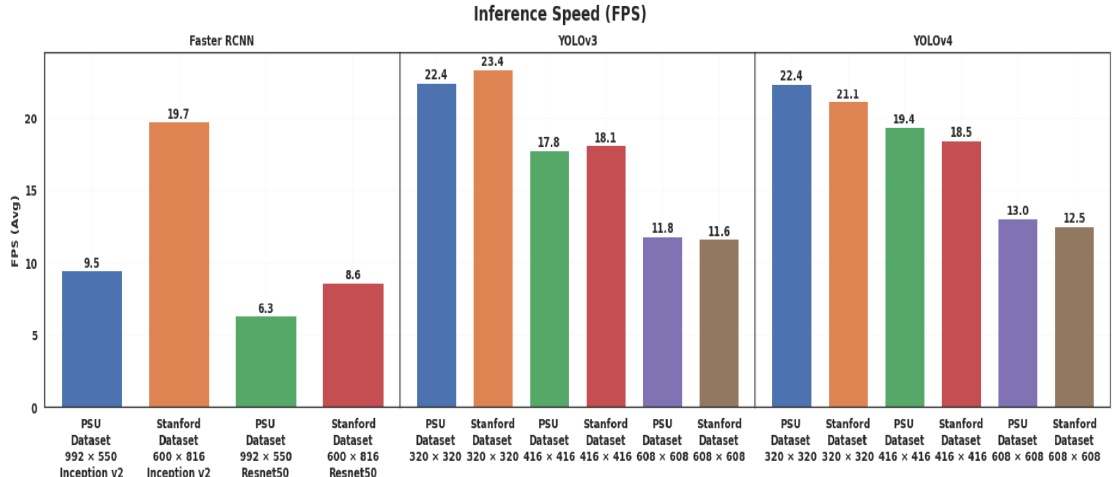
Figure 13. Inference speed measured in frames per second (FPS), for each of the tested algorithms. The input size for YOLOv3 and YOLOv4 is fixed, whereas the value shown for Faster R-CNN is an average of the variable input sizes.